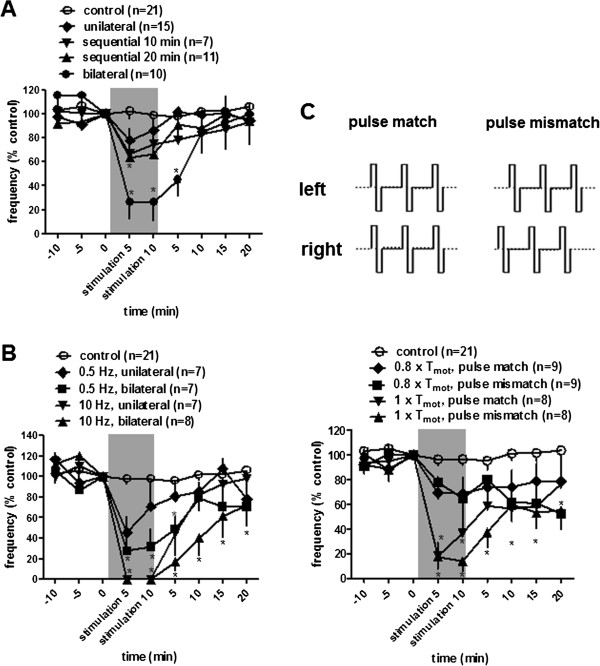
Time course response of frequency of the bladder rhythmic contraction to unilateral and bilateral spinal nerve stimulation (10 Hz, pulse width 0.1 ms) at motor threshold intensity (A), a supra-threshold intensity of 0.6 mA (B) or bilateral 10 Hz neuromodulation in pulse matched or pulse mismatched fashion (C). Schematic drawings of the stimulation waveform of pulse match and pulse mismatch are shown in C. There is no delay or a 50-ms delay between right and left pulses in pulse match or pulse mismatch, respectively. Responses are represented as a percentage of pretreatment values (% control), where the baseline response before stimulation is defined as 100%. * p < 0.05, vs control without stimulation; repeated measures ANOVA, Bonferroni post test. Shaded areas are responses during electrical stimulation.